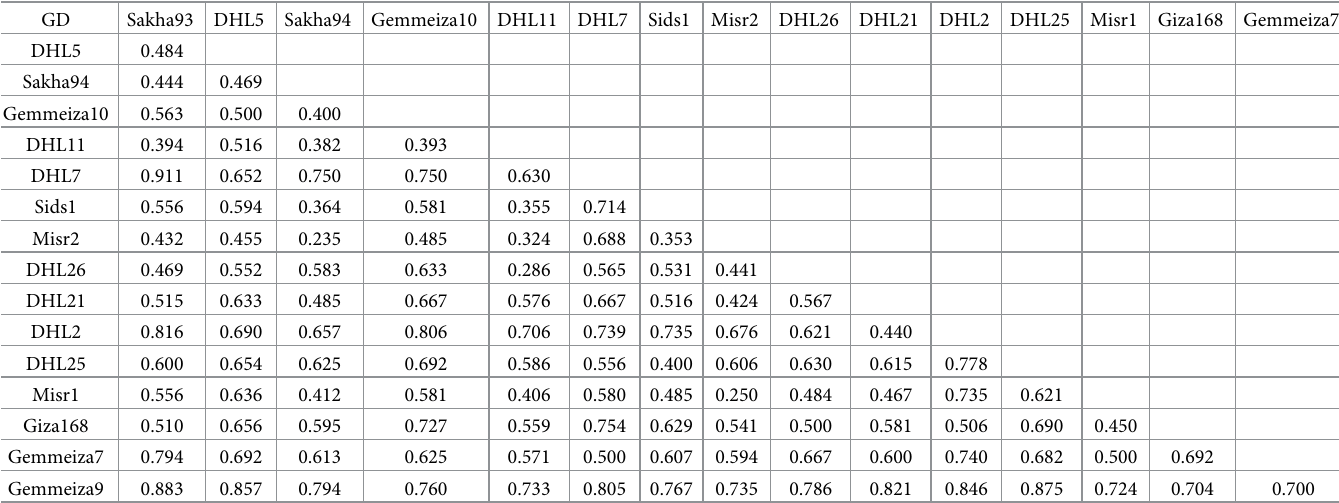
Table 1. Genetic Distance (GD) estimation between the 16 wheat genotypes by using SSR molecular markers. GD